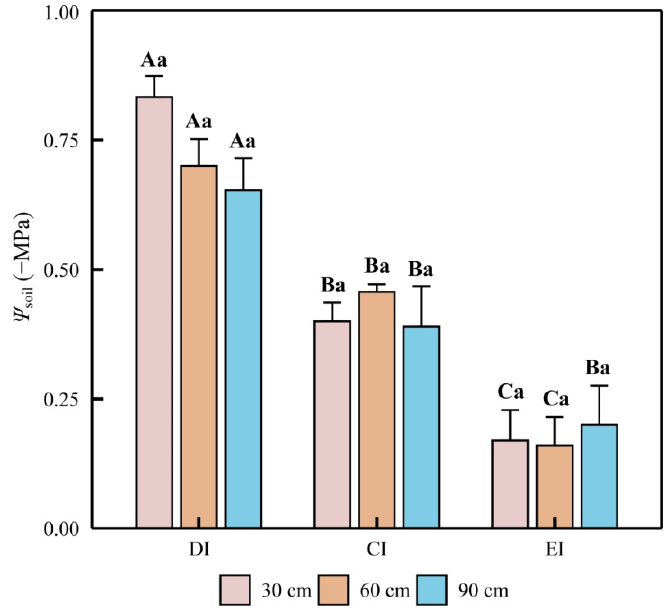
Figure 1. Soil water potential ( Ψ soil ) at different soil depths. Different lowercase letters indicate significant differences ( p < 0.05) between different soil depths for the same treatment; different capital letters indicate significant differences ( p < 0.05) between different treatments for the same soil depth (mean ± standard error, n = 3).